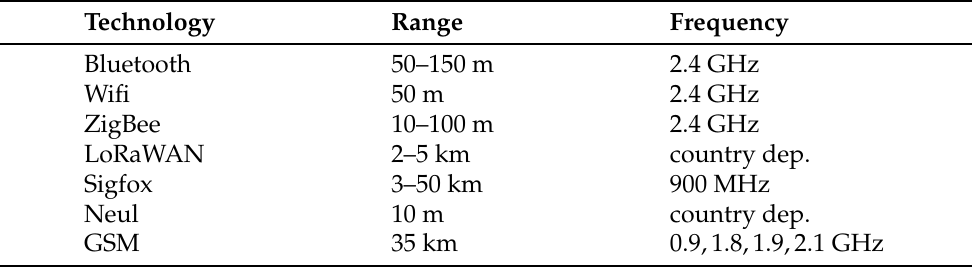
Table 1. More diffused radio networks used for IoT applications, with typical coverage and frequency (from Farooq et al. [32]). GSM—Global System for Mobile